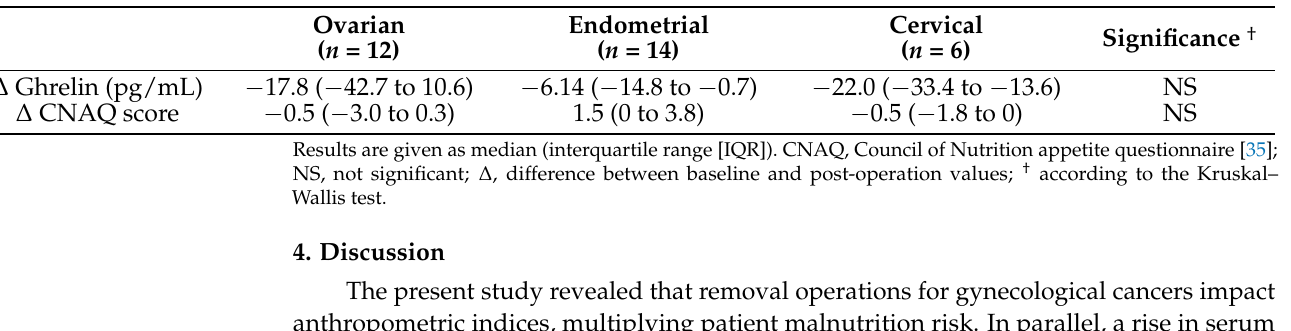
Table 4. Changes ( ∆ ) in post-operative objective and subjective appetite assessment compared to the baseline, according to the site of gynecological